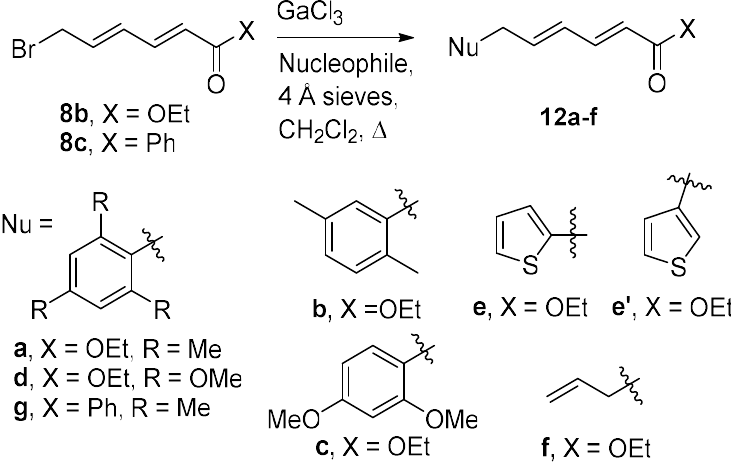
Table 3. Results for condensation reactions of 8b , 8c